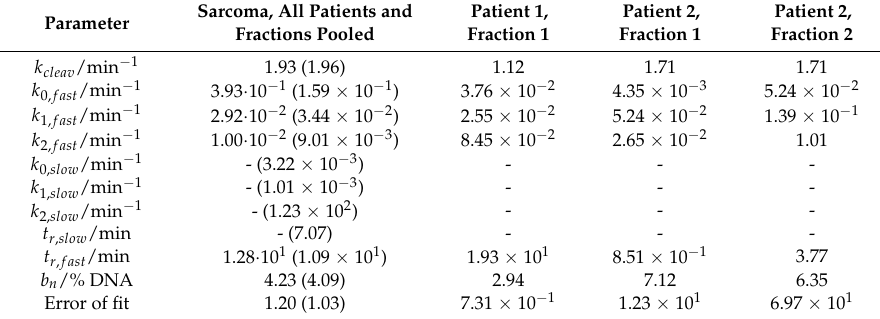
Figure 5. Time resolved comet data fitted by the bio-mathematical model. ( A ) Average of median %DNA in tail of all patients over three fractions for sarcoma cells, with only the fast repair pathway activated; ( B ) median %DNA in tail for the first patient, fraction 1; ( C ) median %DNA in tail for the second patient, fraction 1; ( D ) median %DNA in tail for the second patient, fraction 2. Error bars indicate upper and lower quartiles. The line represents the model prediction with parameters from Table 4. Table 4. Parameter sets of the bio-mathematical model for the sarcoma group. For the final repair step, second order kinetics was assumed and the data is given in %DNA. The numbers in parentheses in column 1 (sarcoma, pooled) are for a fit of the full model; for the other values in this column, only one pathway is active. The remaining columns contain the fitted parameters of individual patient